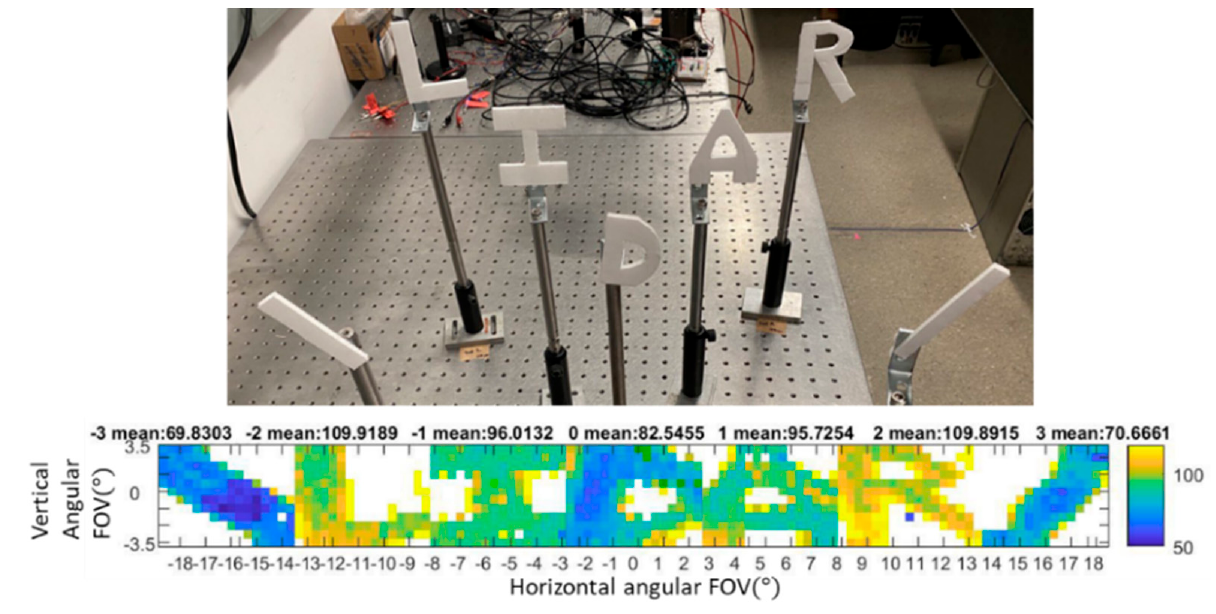
Figure 12. Target placement of “LIDAR” object and its corresponding lidar image reconstruction. The measured distance values indicated above the figure show good agreement with the actual distances of the targets.